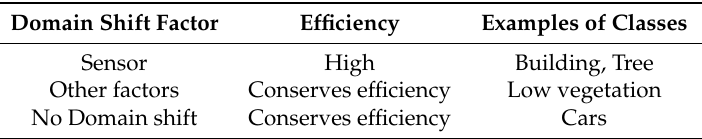
Table 5. Efficiency of our algorithm per